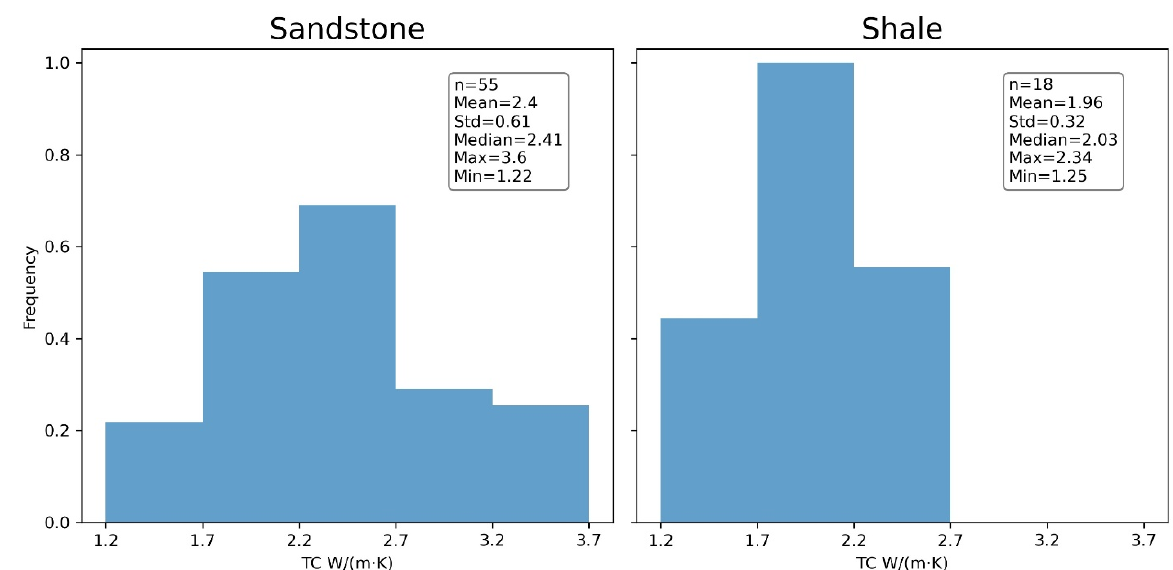
Figure 1. Thermal conductivity histograms obtained from the laboratory testing, note that the frequency has been normal-